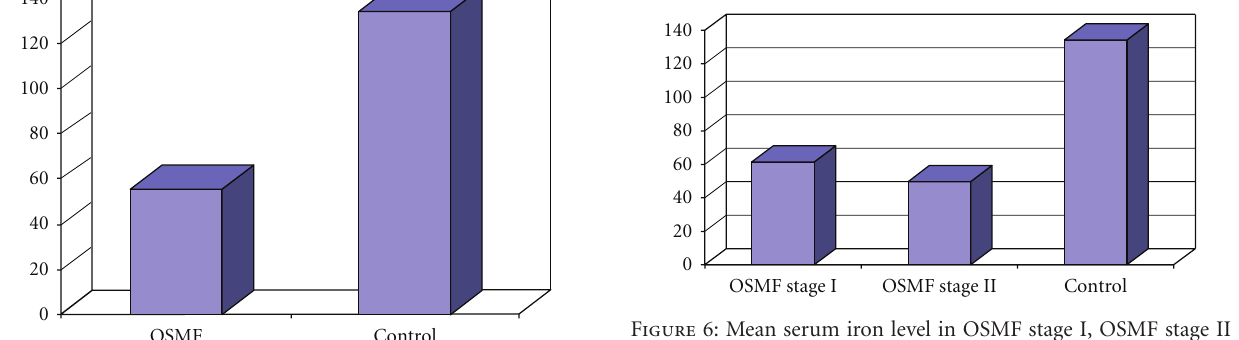
Figure 4: Mean serum iron levels in OSMF and control groups.